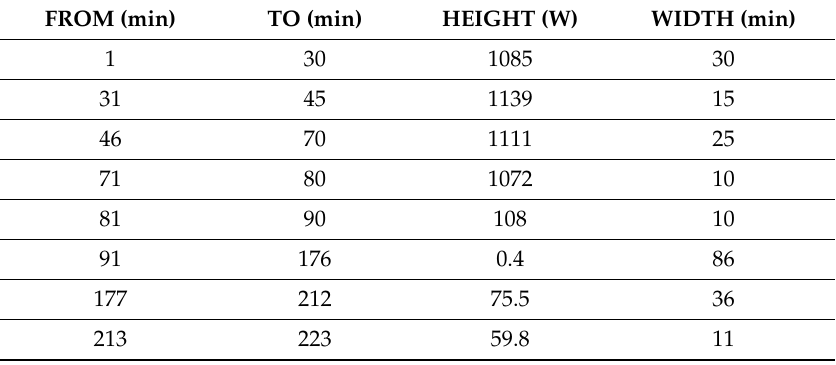
Table 1. Example of Box Model